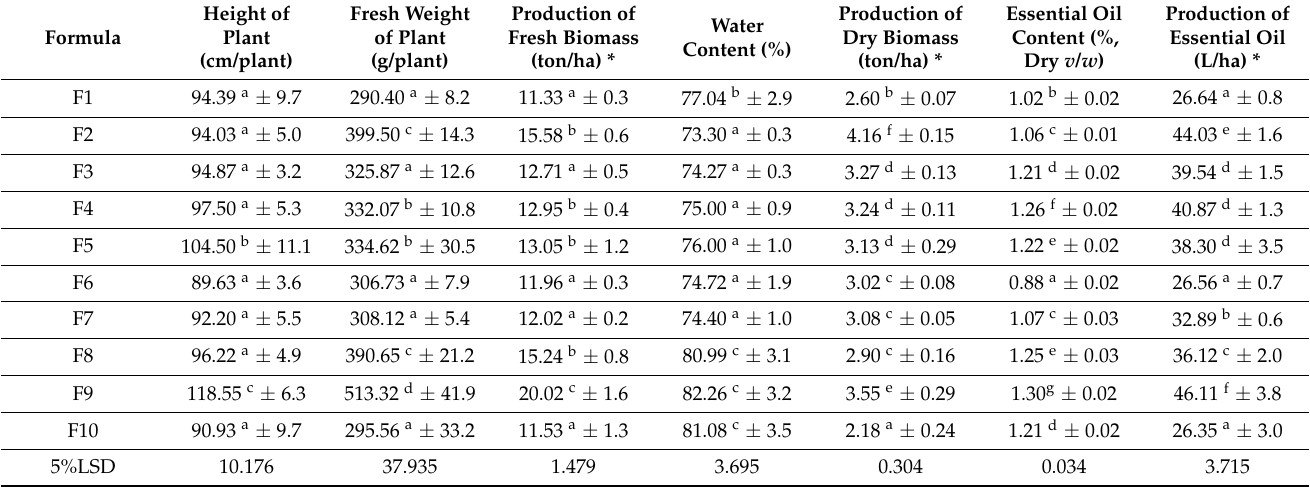
Table 1. Biomass and essential oil production of O. basilicum cultivated under different light conditions.